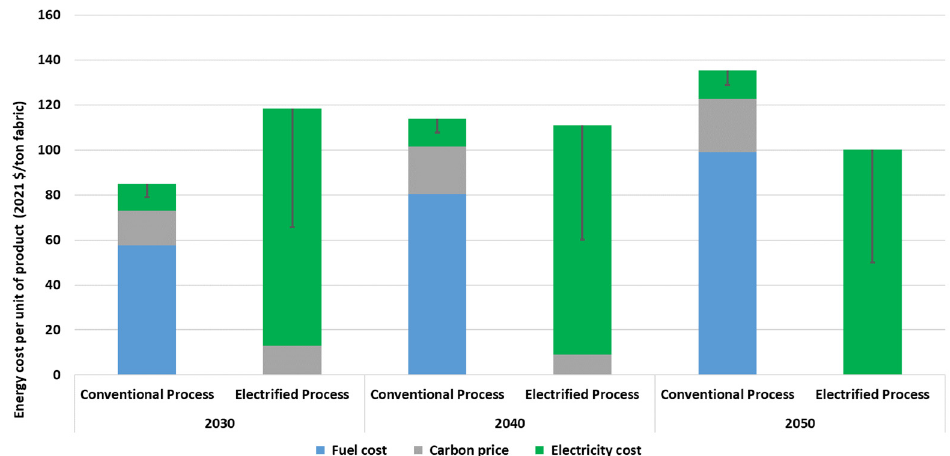
Figure 20. Energy cost per unit of production for conventional and electrified dyeing process in Taiwan.